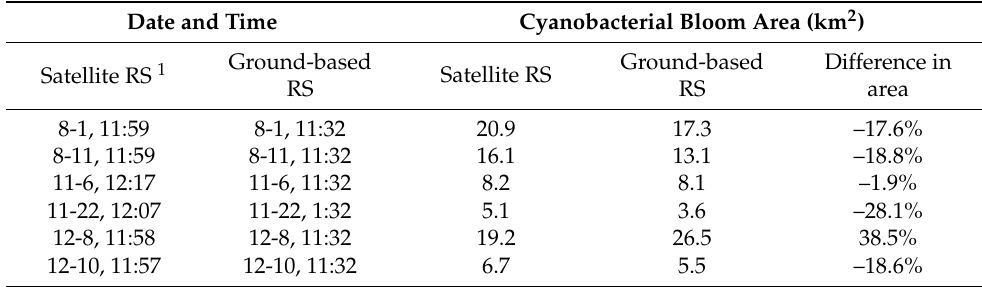
Table 1. Comparison table of satellite remote-sensing data and ground-based remote-sensing data.